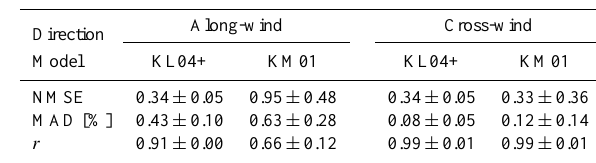
Table B1. Median performance of the footprint parameterizations KL04+ and KM01 compared to the reference Lagrangian model of Kljun et al. (2002). Uncertainty measures NMSE, MAD and r are explained in the